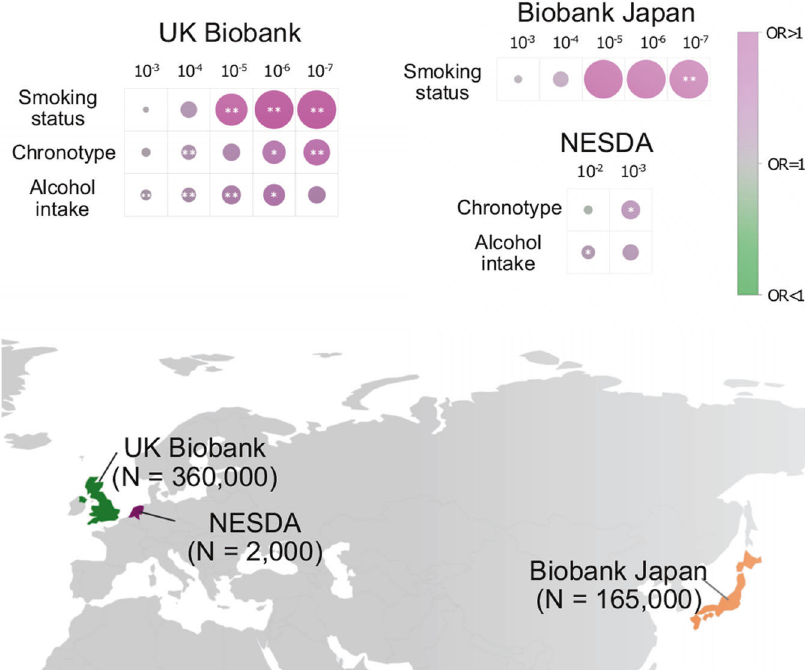
Fig. 4 Analysis of Neandertal DNA associations in the Biobank Japan and Netherlands Study of Depression and Anxiety (NESDA). The three phenotype groups with the largest over-proportional Neandertal DNA associations in the UK Biobank cohort were smoking, sleep, and alcohol. The individual phenotypes in each group that showed the largest contributions to the respective groups ’ enrichment results were smoking status, chronotype, and alcohol intake (top left). For these three phenotypes the odds ratio, re fl ecting the ratio between the number of tag aSNP associations and the average number of associations in 1000 sets of frequency-matched non-archaic tag SNPs is displayed (color and size indicate the average log odds ratio and direction). Using the same method the three phenotypes were among the phenotypes that were tested for the proportional number of Neandertal DNA associations in NESDA (results for the signi fi cant phenotypes of chronotype and alcohol intake are shown on the right). In addition, four smoking phenotypes were tested in Biobank Japan and the results for smoking status — one of the phenotypes with a signi fi cant enrichment result is shown in the top right. A map illustrating the host countries of each cohort and the sample sizes used for this analysis are displayed in the lower part of the fi